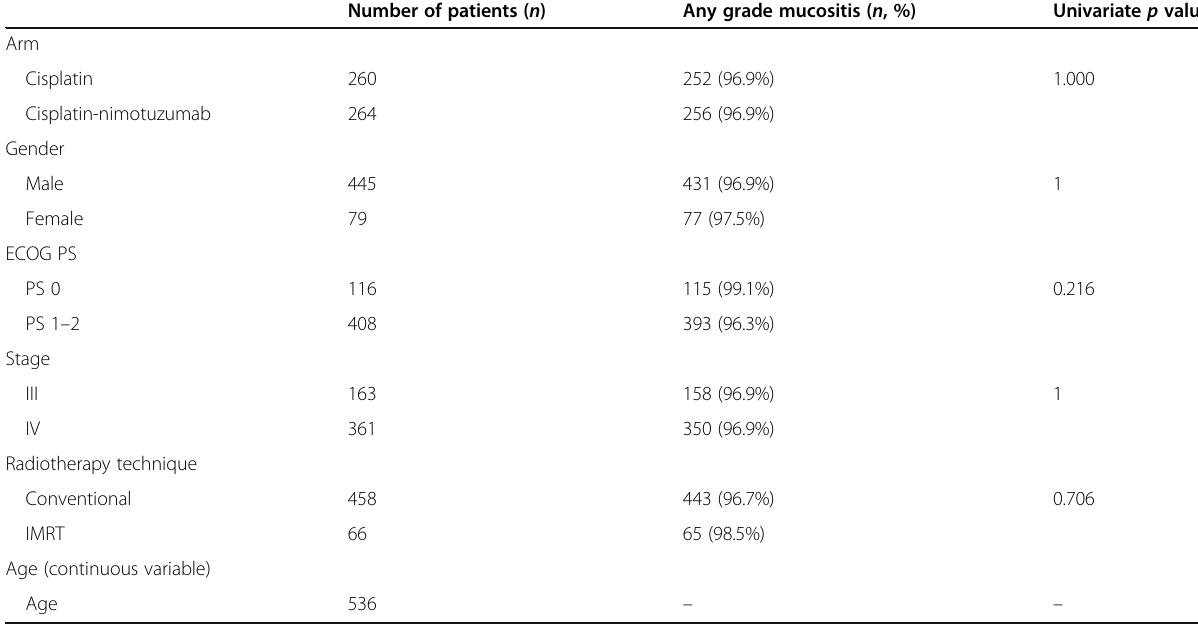
Table 1 Factors affecting any grade oral mucositis